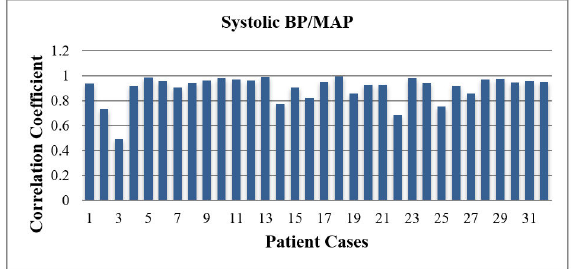
Figure 3. Correlation Results of vital signs for IDH